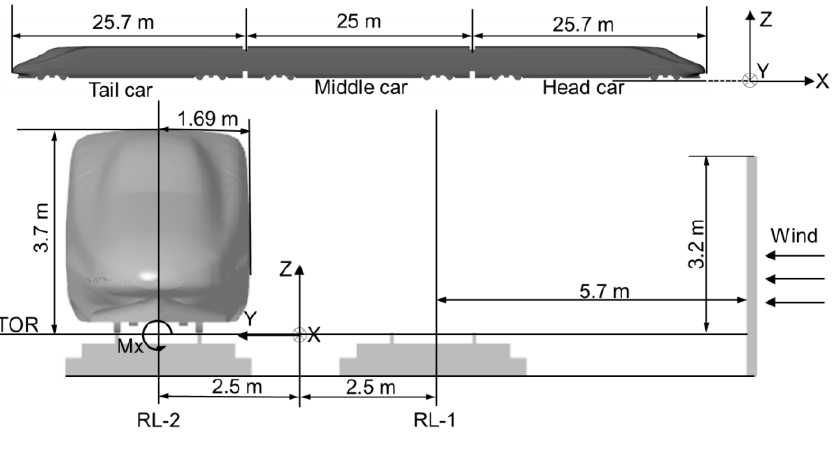
Figure 3. High-speed train model.